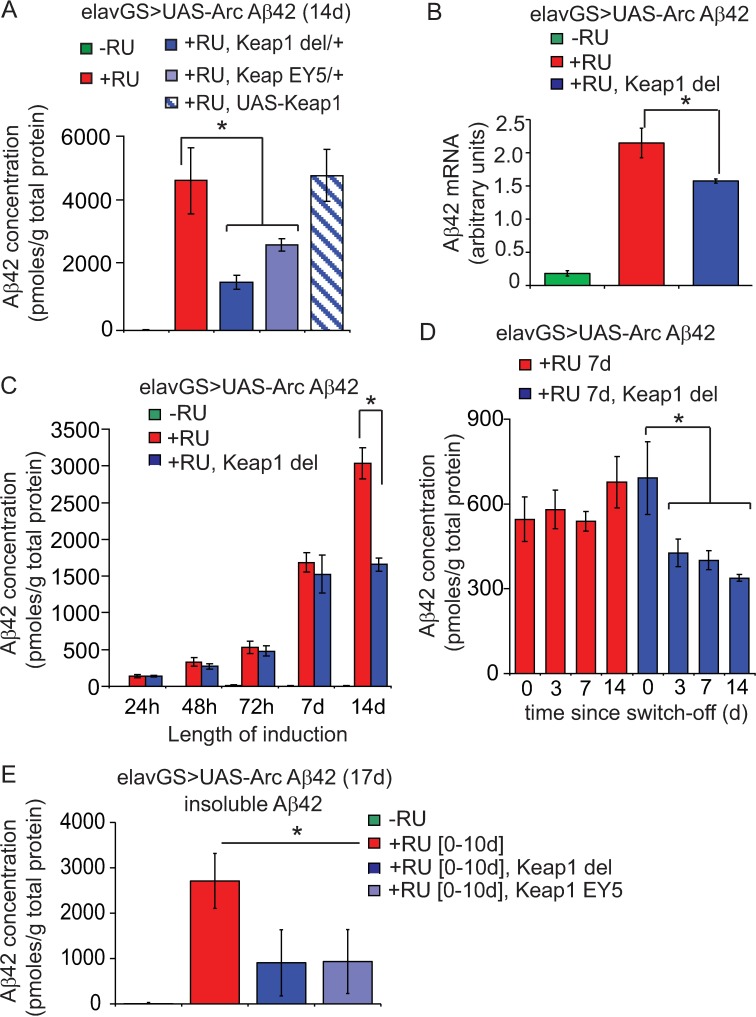
Keap1 inhibition enhances degradation of the Aβ42 peptide.(A) Lowering Keap1 reduced total Aβ42 peptide levels in 14 day-old flies. Data are presented as means ± SEM. P<0.05 comparing +RU or +RU, UAS-Keap1 to +RU, Keap1 del or +RU, Keap1 EY5 flies (one-way ANOVA and Tukey’s HSD). N = 4 biological repeats of 5 fly heads per sample. (B) Aβ42 mRNA in 14-day-old Keap1 del flies. Data are presented as means ± SEM. P<0.05 comparing +RU to +RU, Keap1 del flies (one-way ANOVA and Tukey’s HSD). N = 4 replicates of 20 flies per condition. (C) Reducing Keap1 lowered Aβ42 peptide levels, compared to controls. Data are presented as means ± SEM. P<0.05 comparing +RU to +RU, Keap1 del following 14 days of induction. No significant difference was observed between genotypes at all other time-points (two-way ANOVA and Tukey’s HSD). N = 3–4 replicates of 5 fly heads per condition. (D) Inhibition of Keap1 led to the degradation of Aβ42 peptide following removal of the inducer RU486. Data are presented as means ± SEM. P<0.05 comparing +RU 7d, Keap1 del flies at 0 to 3, 7 and 14 days following switch-off. No significant difference was observed between time-points following switch-off for +RU 7d control flies (two-way ANOVA and Tukey’s HSD). N = 4 repeats of 5 fly heads per condition. (E) Analysis of insoluble Aβ42 peptide (see methods) in 17-day-old Keap1 LOF flies following 10 days RU486 induction and 7 days switch-off. P<0.05 comparing +RU, to +RU, Keap1 del or +RU, Keap1 EY5 flies (one-way ANOVA and Tukey’s HSD). N = 3–4 biological repeats of 5 fly heads per sample.